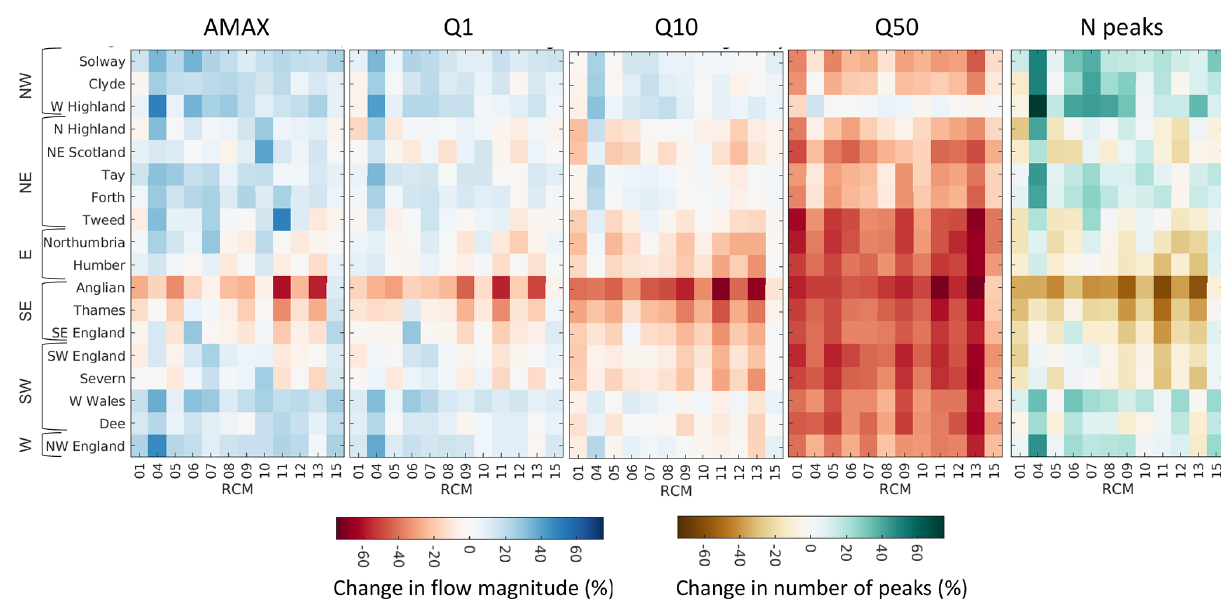
Figure 5. Heat maps showing region-average changes in flow magnitude between the baseline and future periods, for all 12 RCMs. Regions have been ordered by location, with the relative position within GB given on the left. To focus on differences between RCMs, the median flow value from the hydrological model parameter sets is